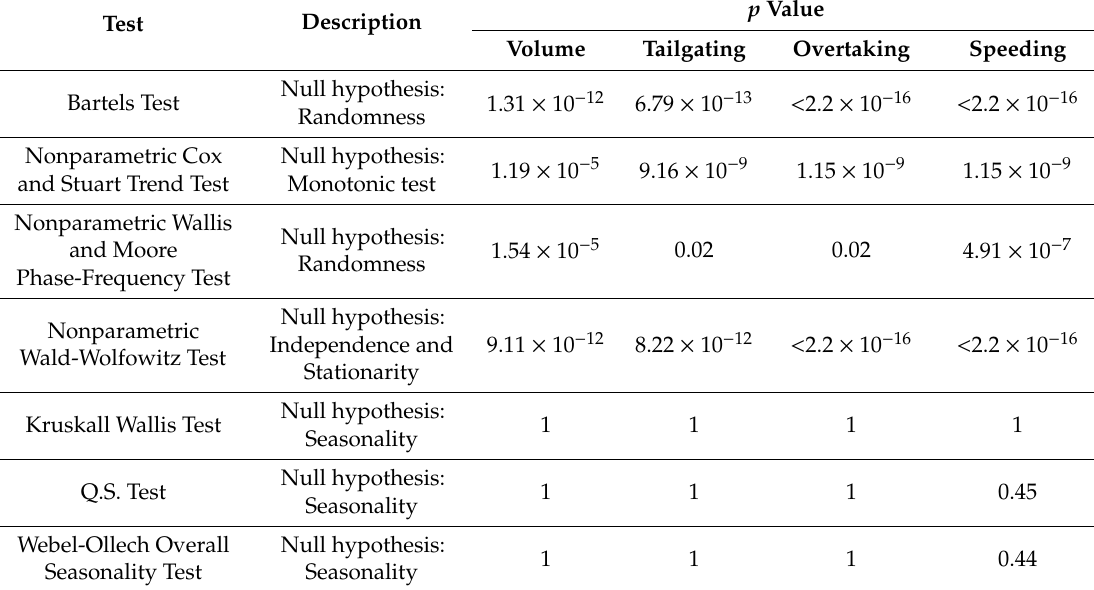
Table 2. Results of Seasonal and Trend tests.